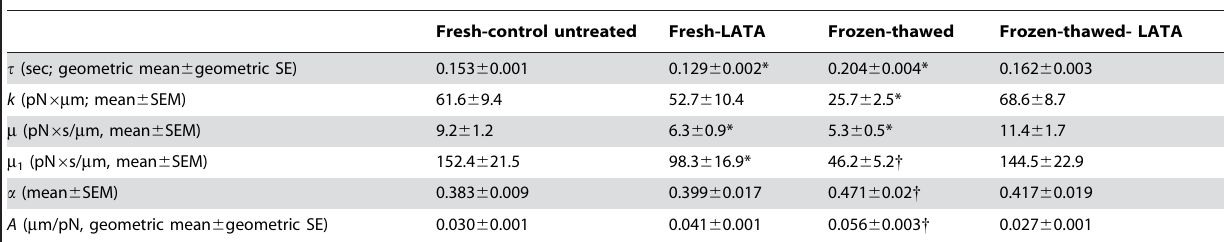
Table 1. Viscoelastic